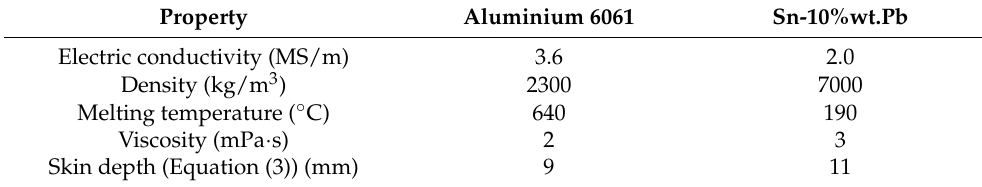
Table 1. Physical properties of materials at melting temperature (liquid).